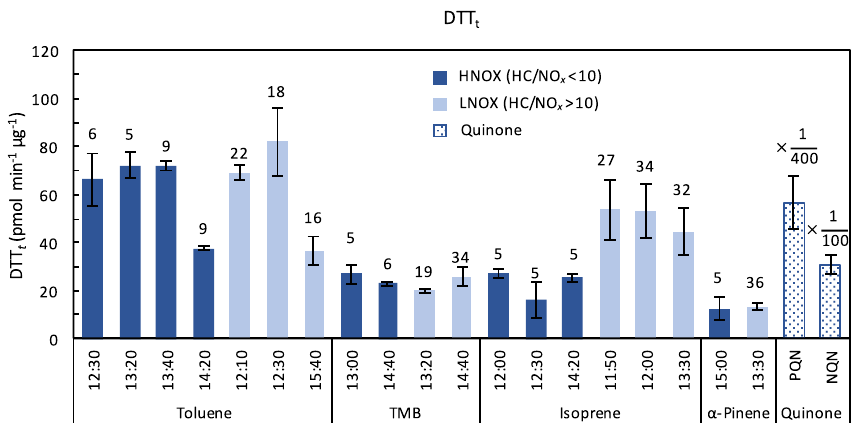
Figure 2. DTT t of chamber-generated SOA under varied NO x conditions (HNOX: high NO x ; LNOX: low NO x ) and positive controls (i.e., PQN and NQN). The number above each column represents the initial HC / NO x ratio. The x axis represents the mid-collection time (Table 1). The DTT t of PQN and NQN is divided by 400 and 100, respectively. Each error bar was calculated by t 0 . 95 × σ/ is the t score (4.303 for n = 3 replicates) with a two-tail 95% confidence level.